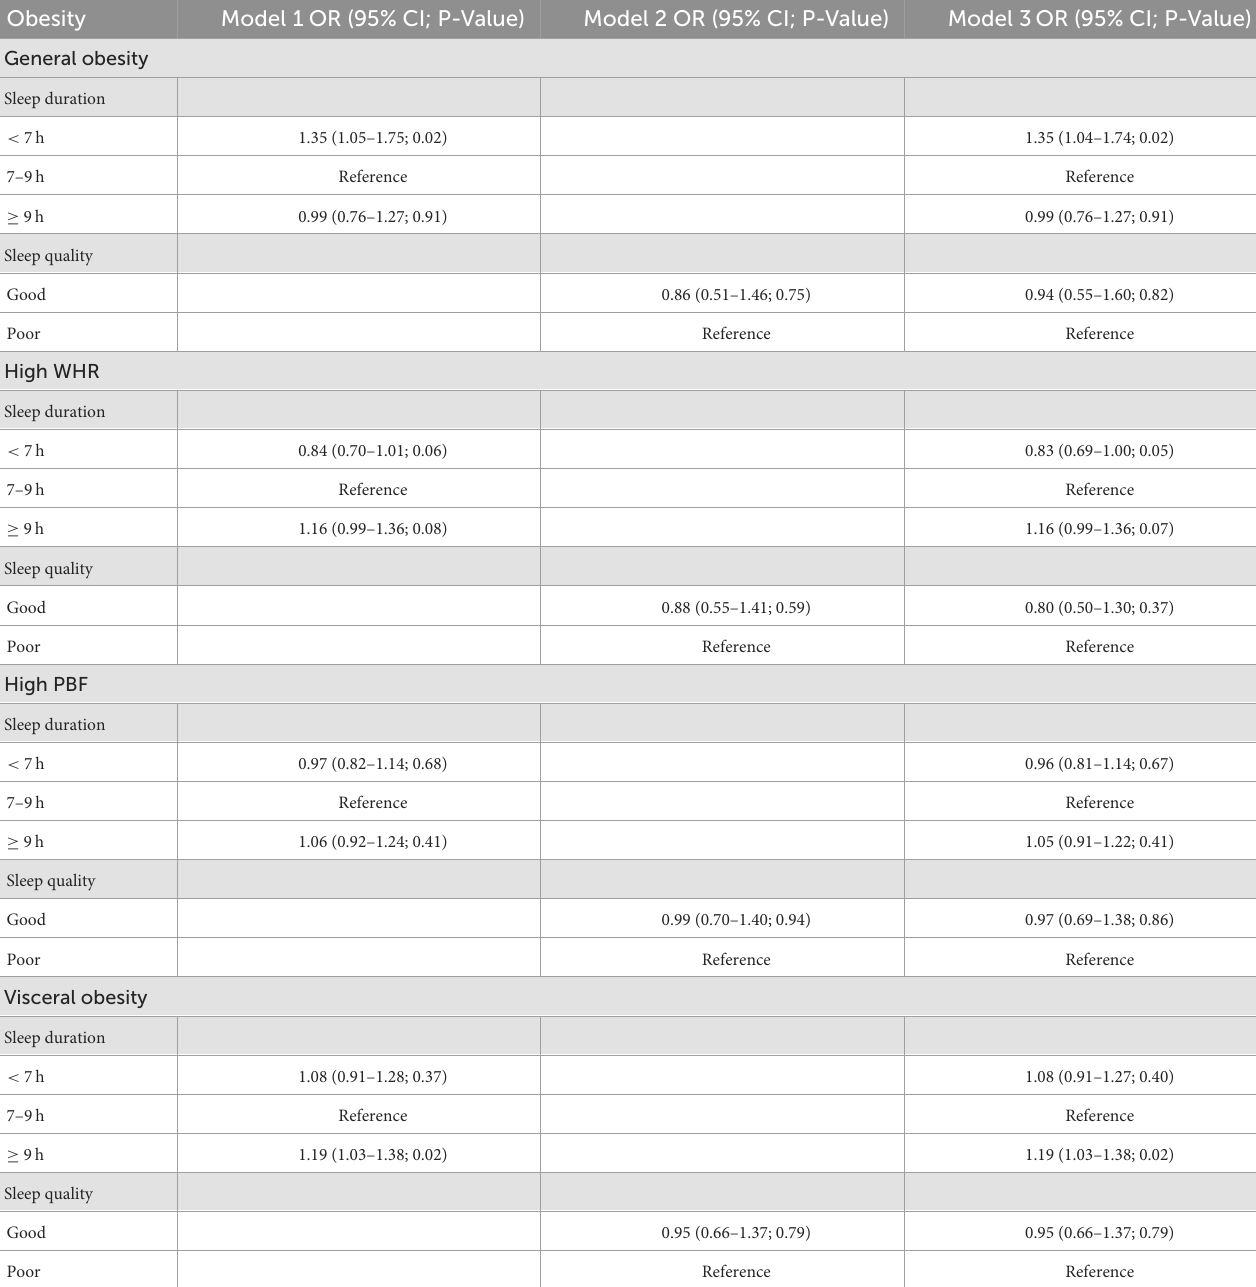
TABLE 3 The association between sleep duration and obesity defined by different indices.